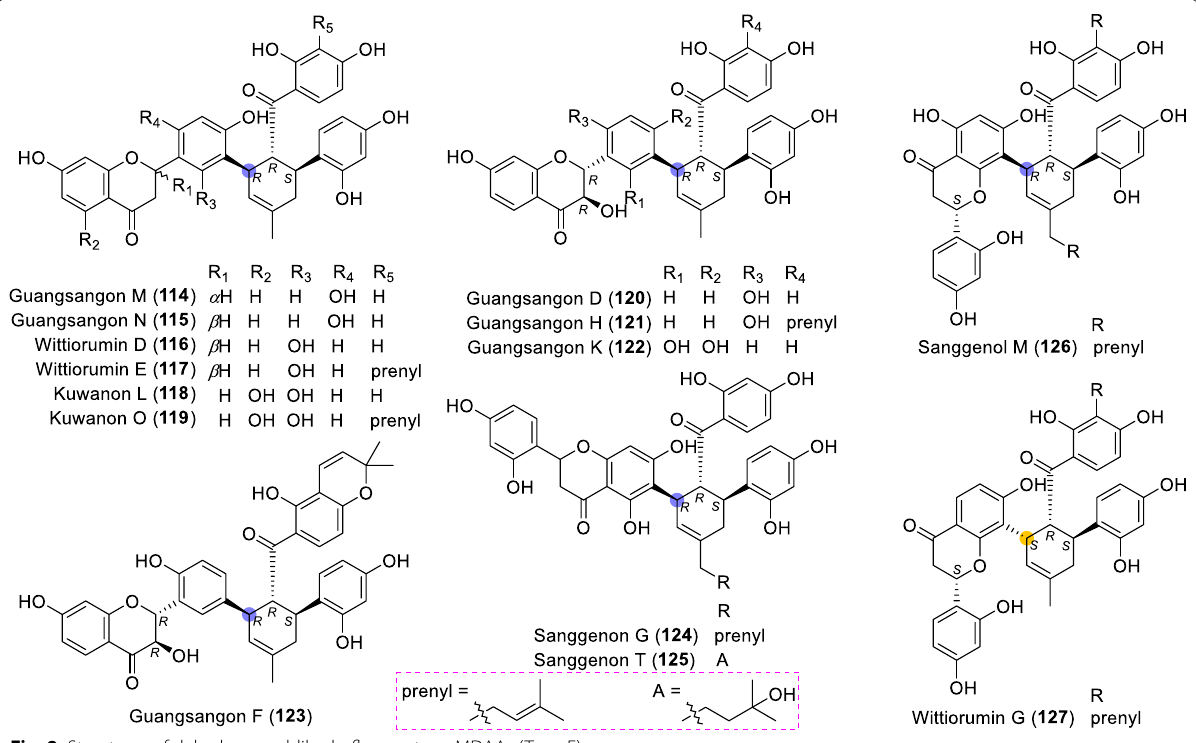
Fig. 8 Structures of dehydroprenyldihydroflavone type MDAAs (Type